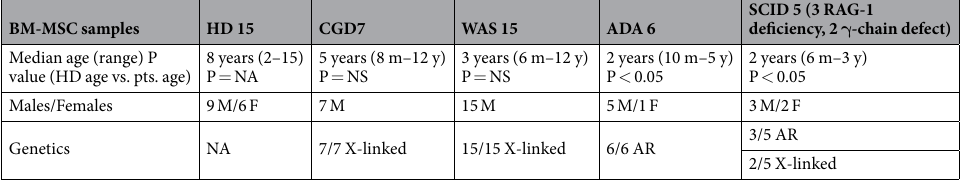
Table 1. Characteristics of PID patients and HDs at time of MSC isolation. Abbreviations: BM, bone marrow; MSC, mesenchymal stromal cell; HD, healthy donor; CGD, chronic granulomatous disease; WAS, Wiskott- Aldrich syndrome; SCID, severe combined immune deficiency; ADA, adenosine deaminase deficiency; RAG, recombination activating gene; m, months; y, years; pts: patients; NA, not applicable; NS, not significant; M, males; F, females; NA, not available; AR, autosomal